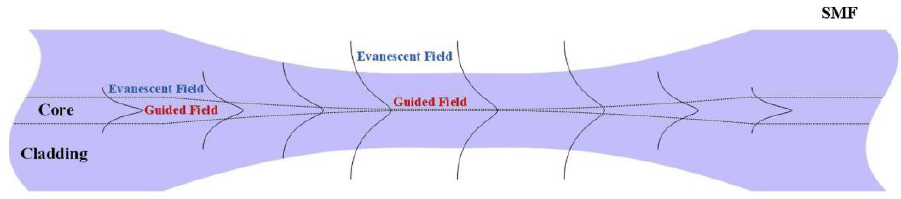
Figure 1. Propagation of light through a narrowing [16].